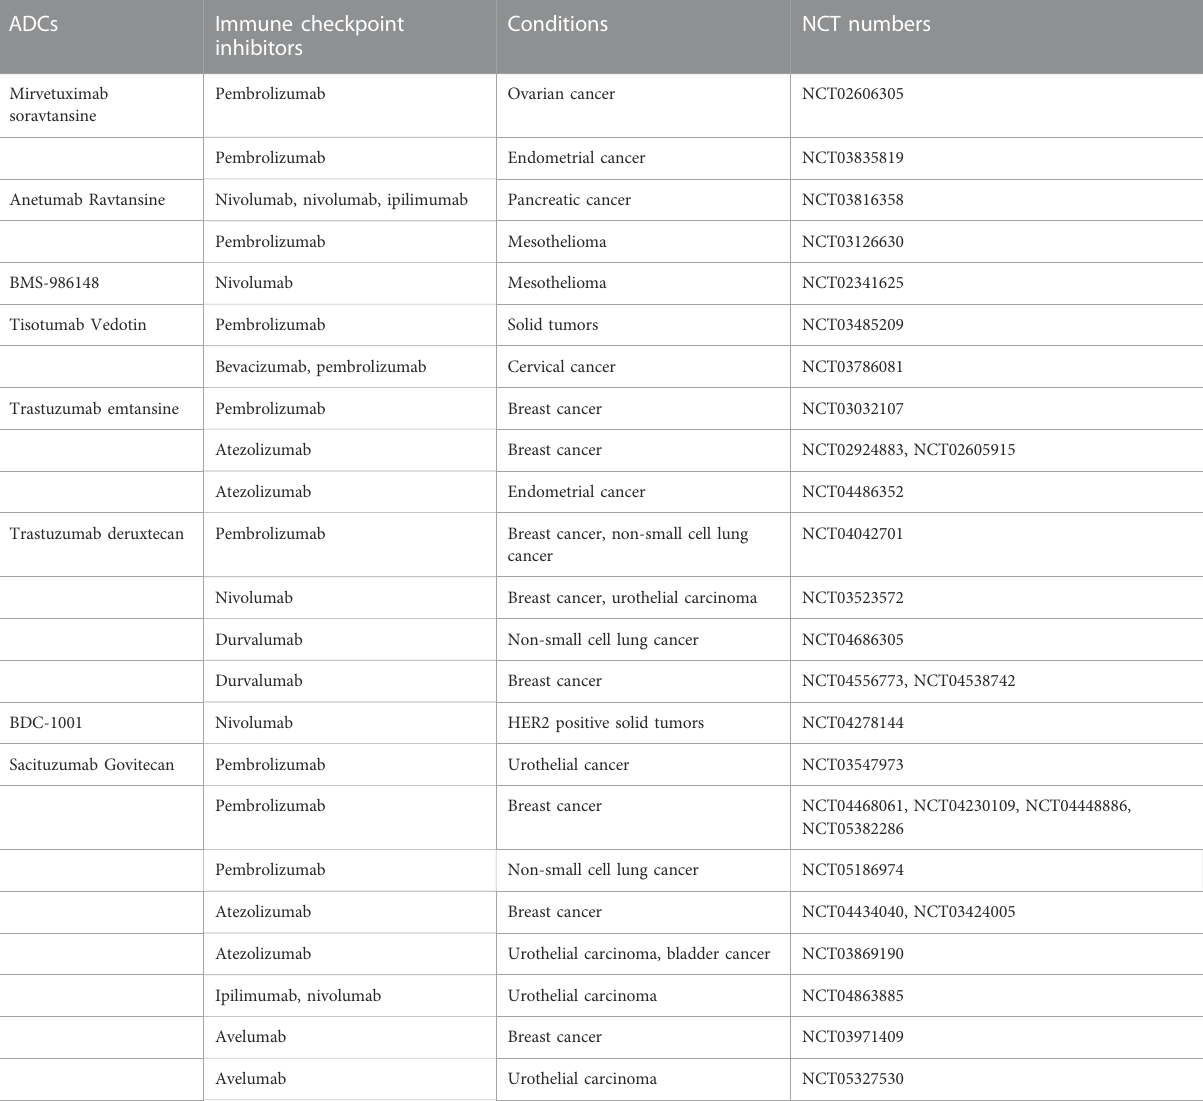
TABLE 5 ADCs in gynecologic oncology combined to immune checkpoint inhibitors in clinical